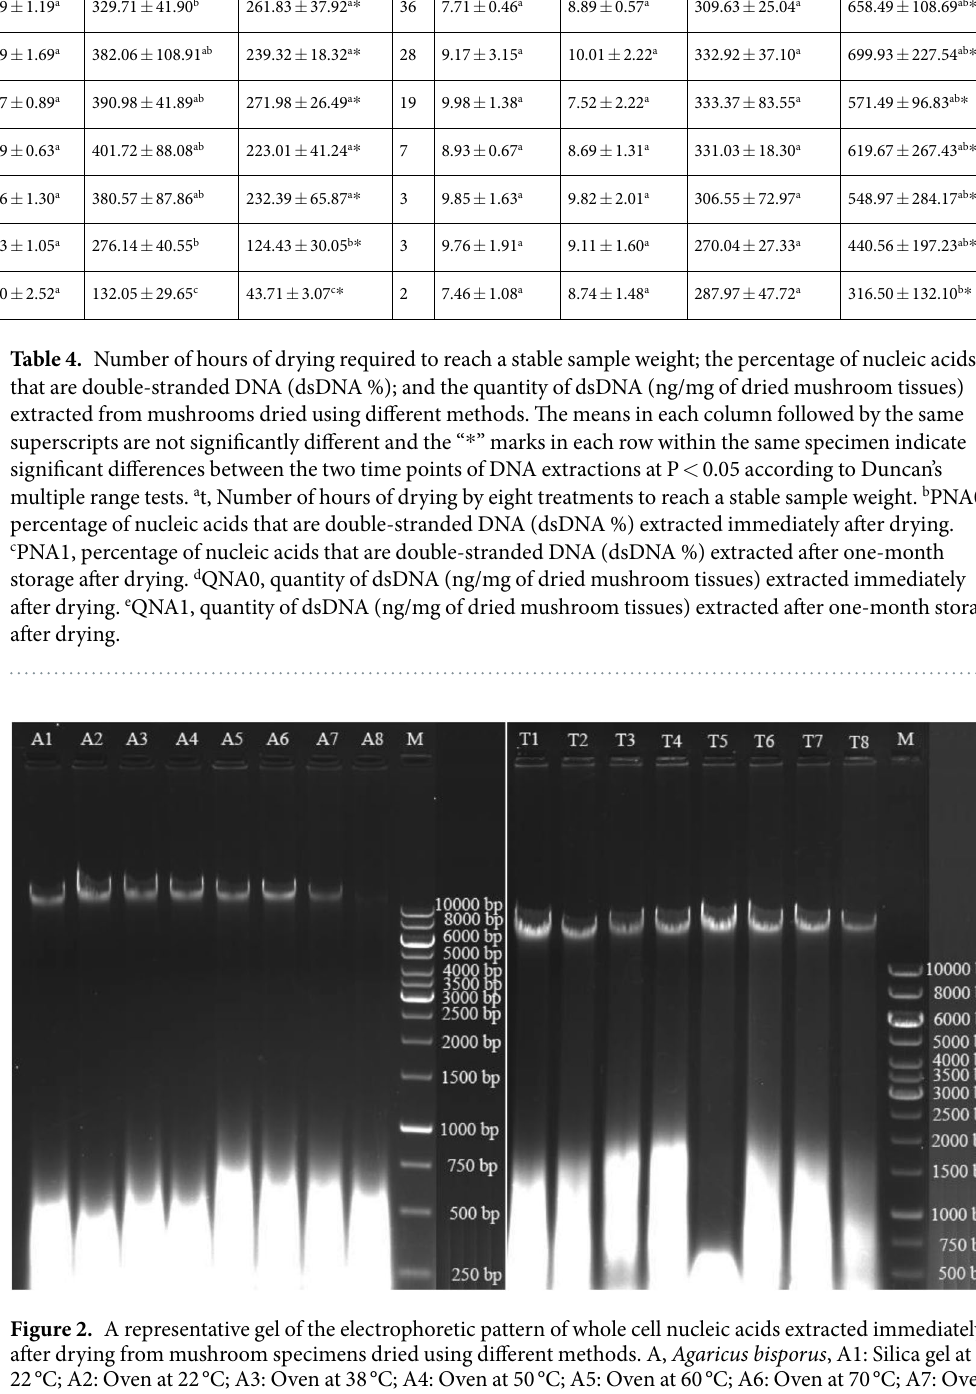
unable to use BioAnalyzer (which has an upper limit of ~10–12 kb) to check the DNA quality from each of the drying methods based on the relative proportions of individual DNA fragment lengths. Here, instead of using the